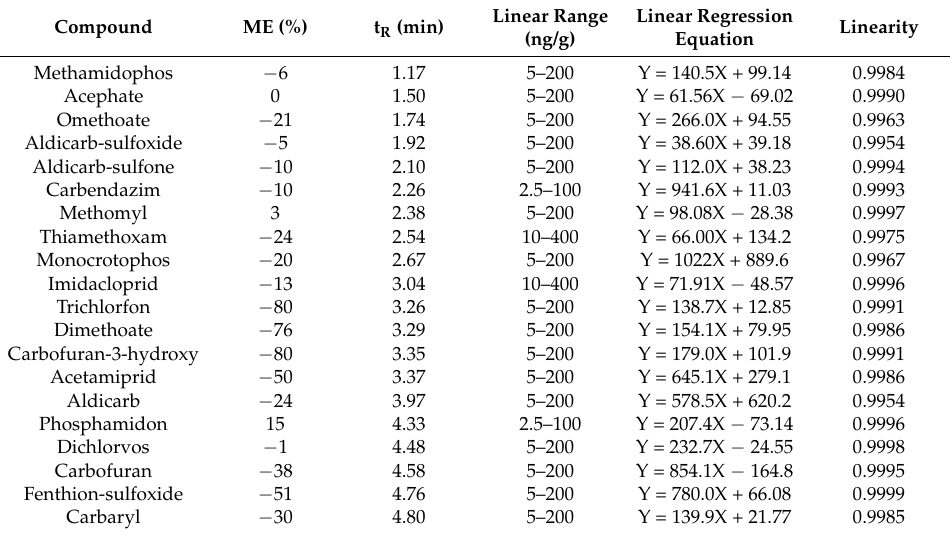
Linear Range Linear Regression (ng/g)